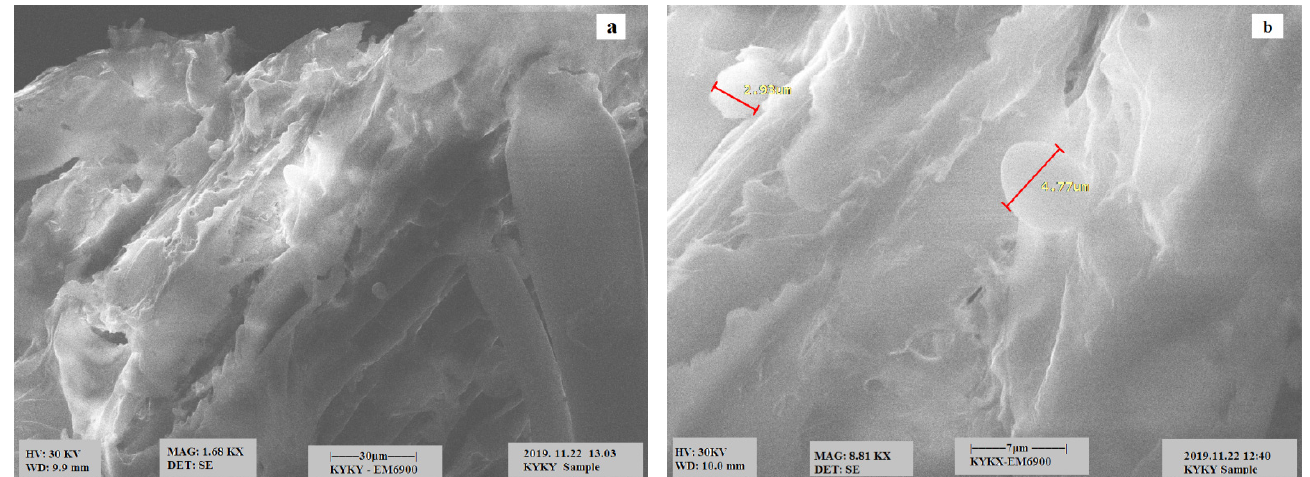
Figure 1. SEM images of the corncob under magnification of 1.68K× ( a ) and 8.81K× ( b ).